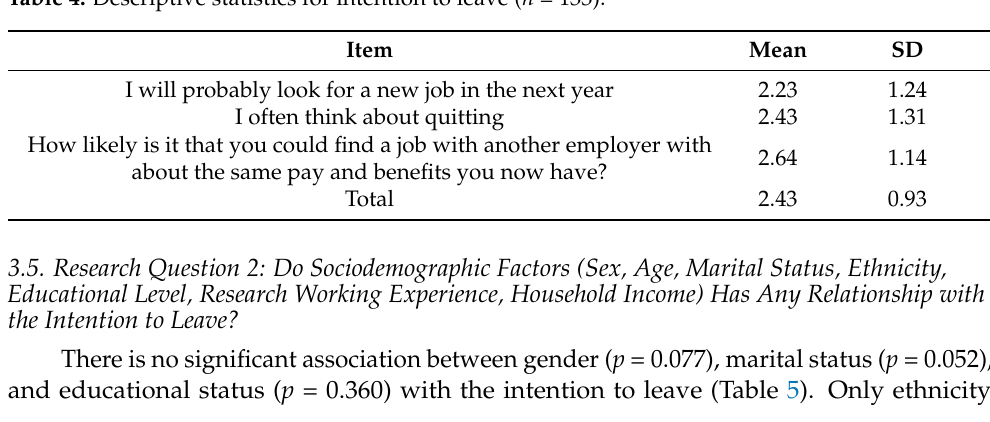
Table 4. Descriptive statistics for intention to leave ( n =